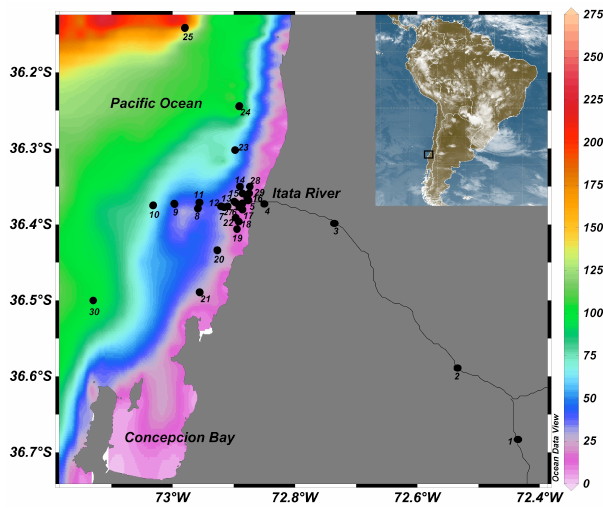
Fig. 1. Study area and location of the sampling stations in the coastal ocean adjacent to the Itata River off Central Chile. Map generated using the software Ocean Data View (Schlitzer, 2010). Color scale in the ocean represents depth in meters as shown in the bar to the